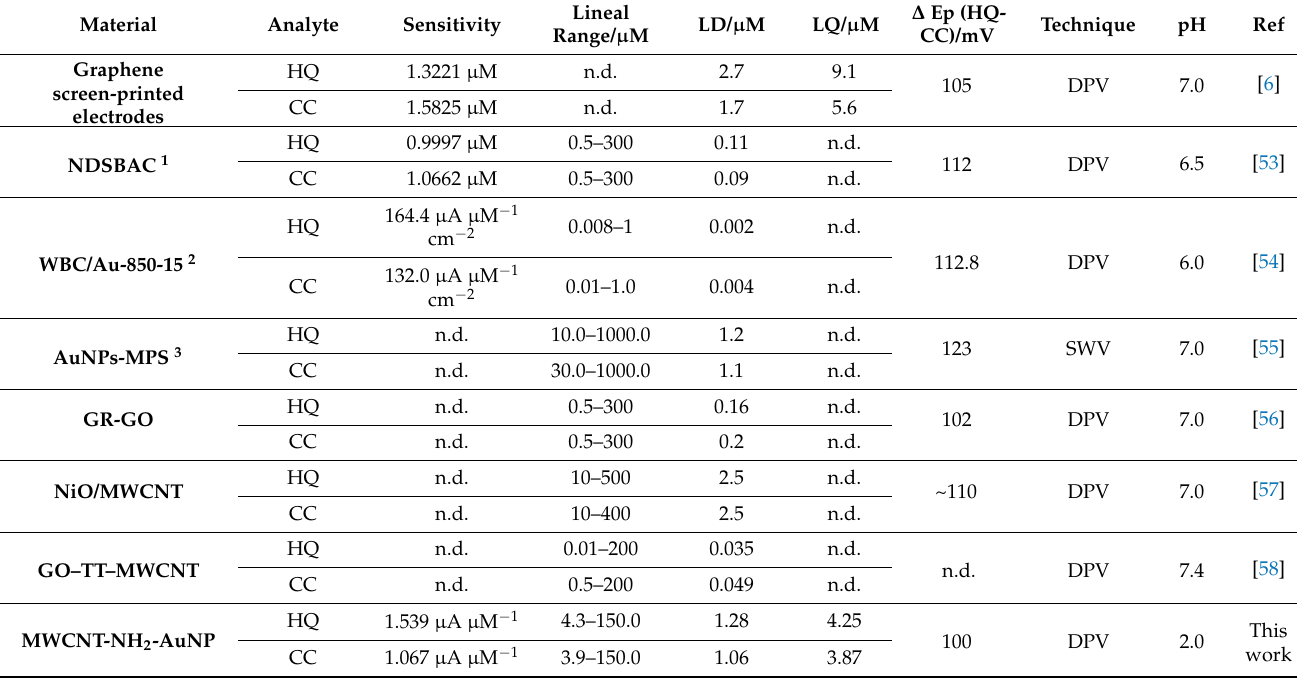
Table 1. Comparison of different sensors reported for the simultaneous determination of HQ and